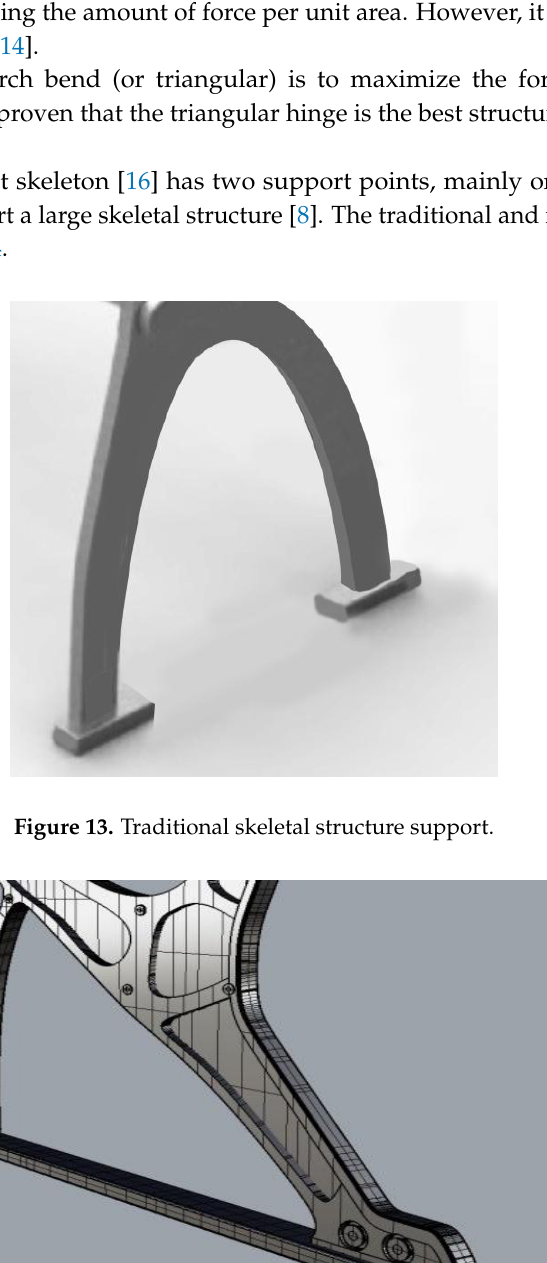
Figure 12. Redesigned structure.